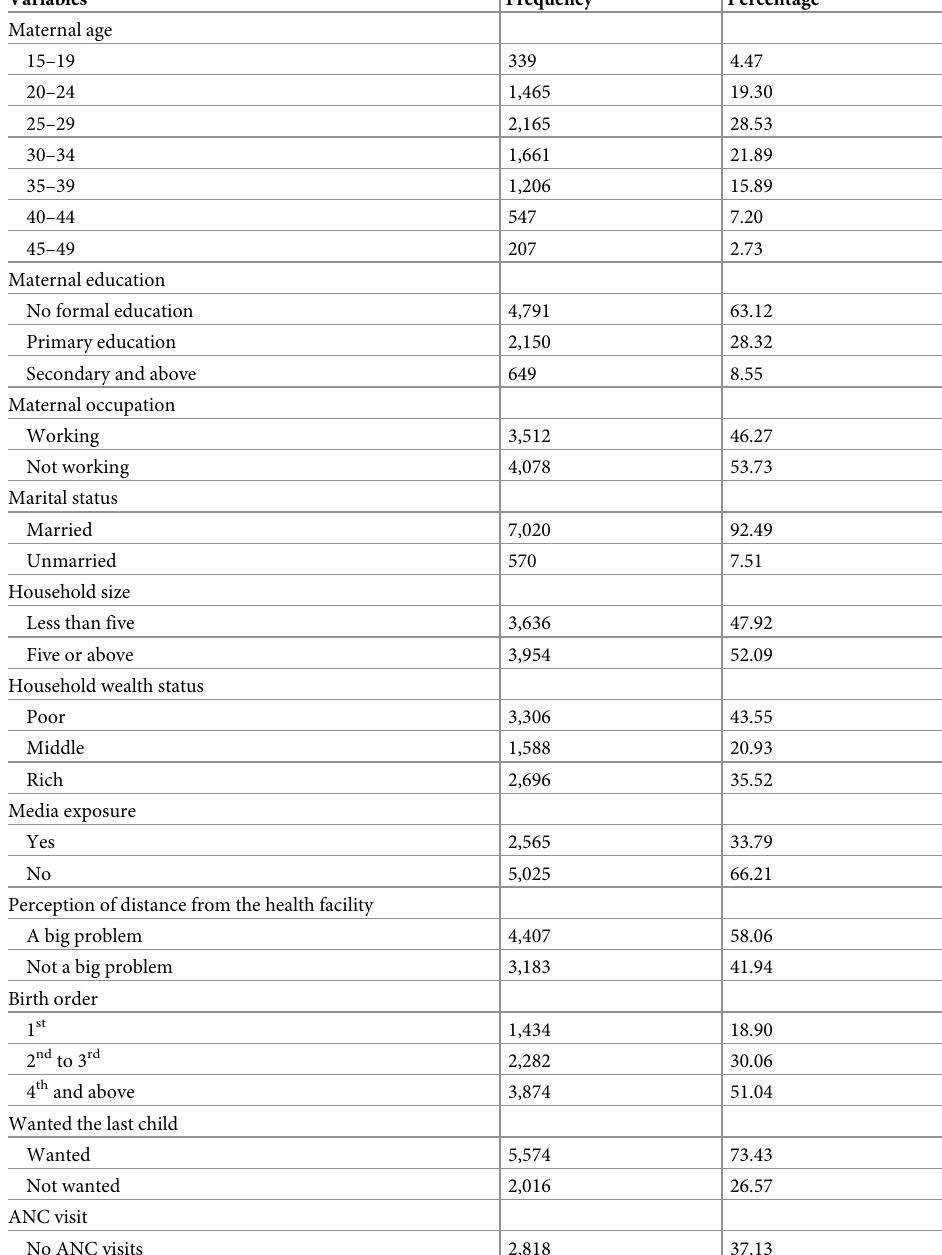
Table 1. Respondents sociodemographic